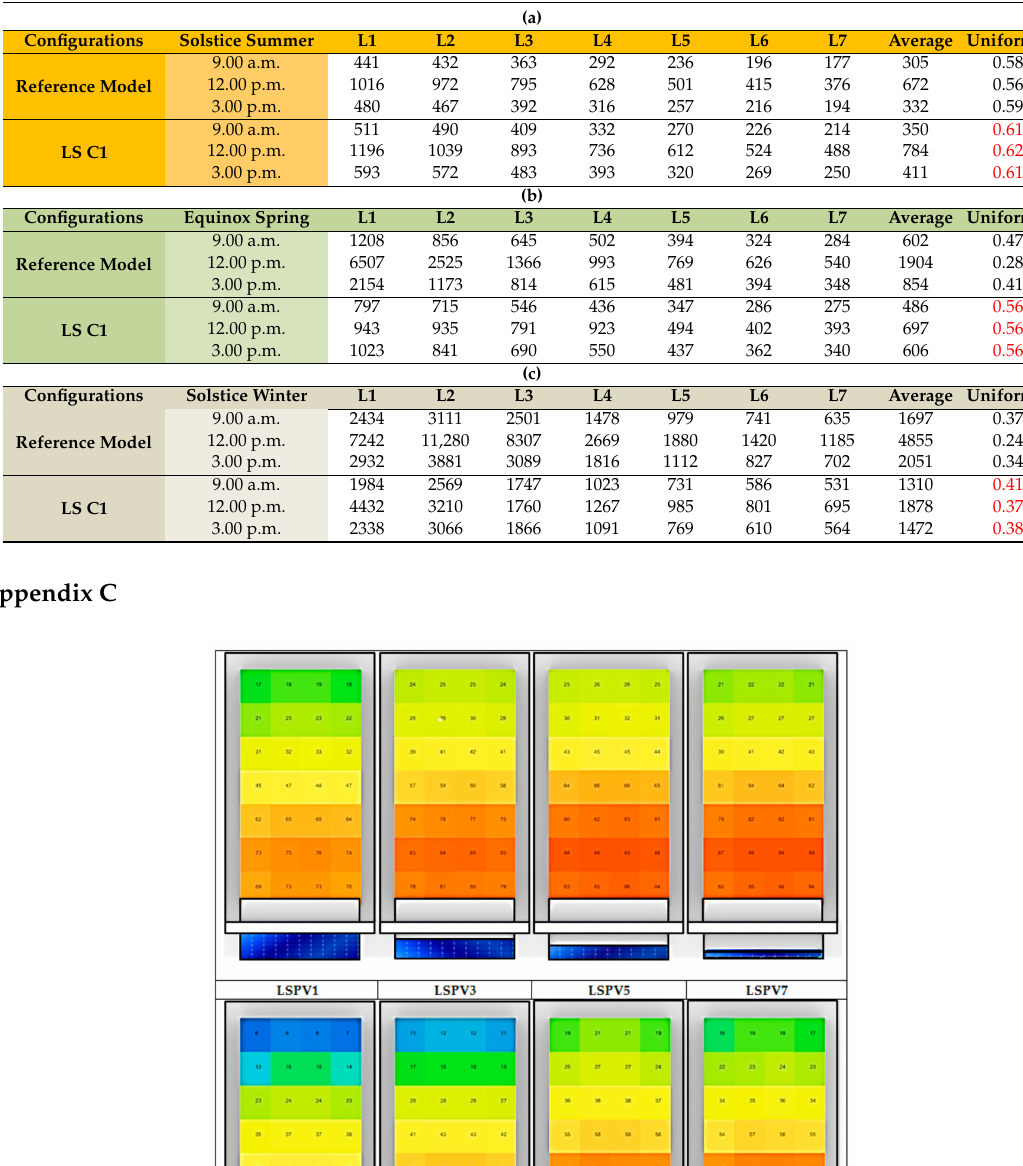
Table A1. The distribution of absolute work plan illuminance (WPI) and uniformity of the reference model compared to the optimized internal and external light shelves without integrating a solar module in ( a ) solstice summer, ( b ) equinox spring, and ( c ) solstice winter.